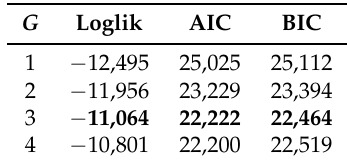
Table 4. Model selection.